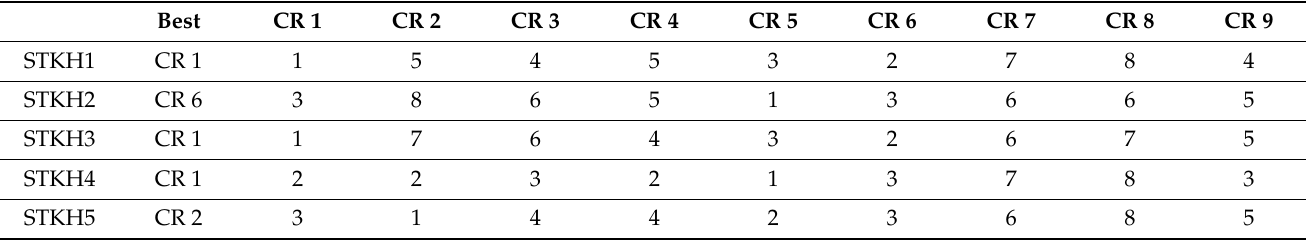
Figure A1. Schematic flowchart of stakeholders and their associated criteria and alternatives for Scenario 1. Table A1. Preference values assigned to criteria by